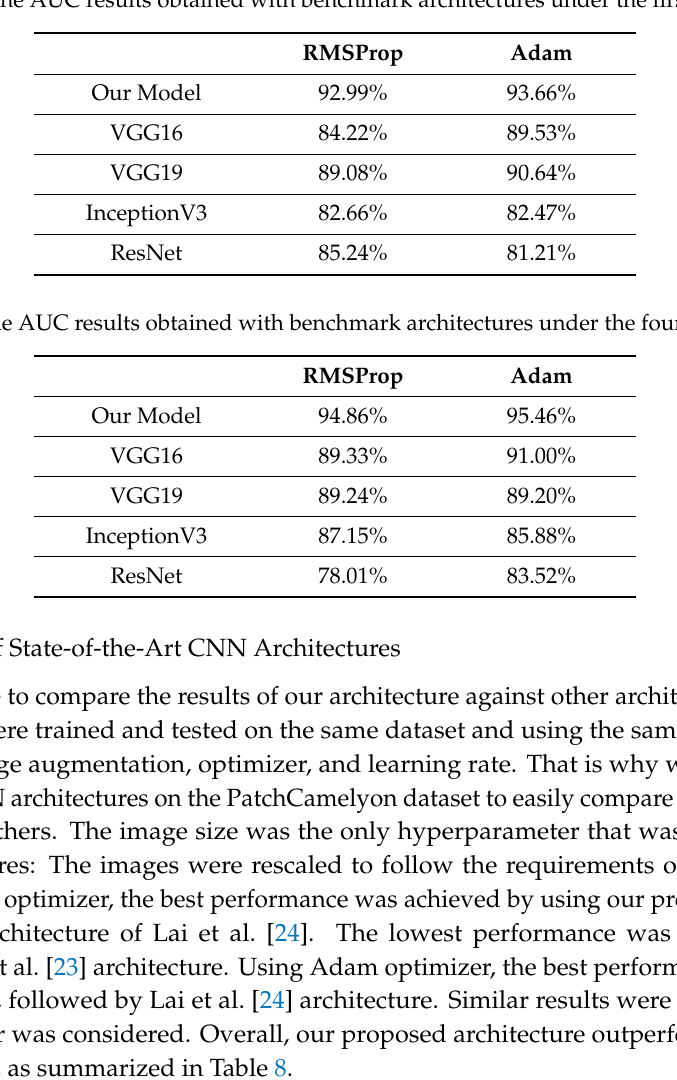
Table 6. The AUC results obtained with benchmark architectures under the first design.